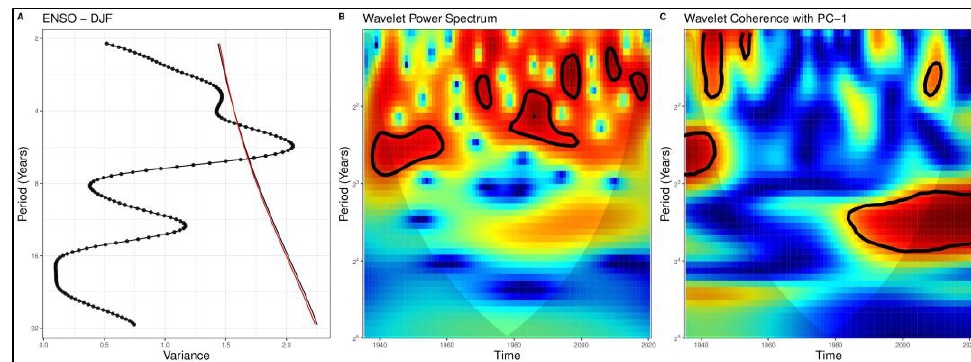
Figure 7. PC-1 and ENSO Index. ( A )—Global wavelet spectrum of ENSO index. The red and black line in the global wavelet spectrum denote the 90% level relative to a hypothesis of red or white noise. ( B ) Wavelet power spectrum of the ENSO index. ( C ) Wavelet coherence between the 1st principal component of the data and the ENSO index. Warmer colors denote higher power/correlation, while cooler colors denote lower power/correlation. The regions bounded in thick contour lines are significant.